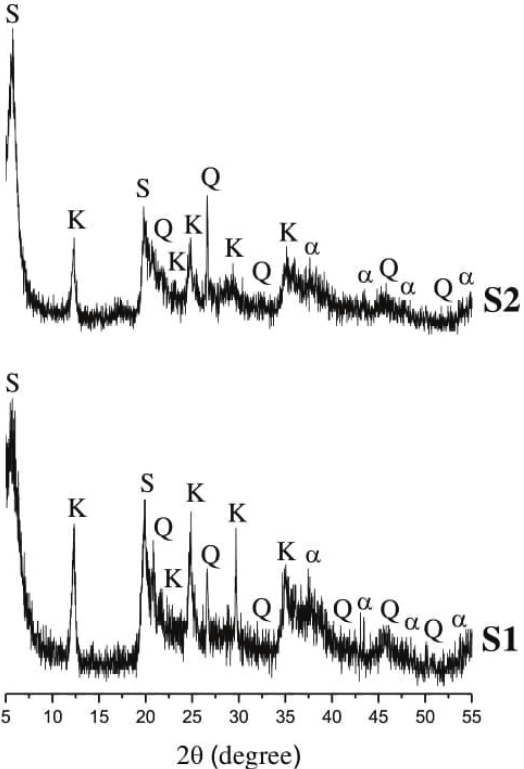
Figure 1. XRD patterns of formulations S1 and S2. S = smectite; K = kaolinite; Q = quartz and α = α-Al